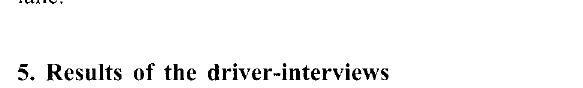
About I 0% of the cars in the morning traffic and all the buses use the HOY-lane, but the number of users varies strongly in the IS-min-intervals. The highest rates of HOY-lane users appear between 7:00 and 7:45 am, (13% up to 25% of all personal cars).